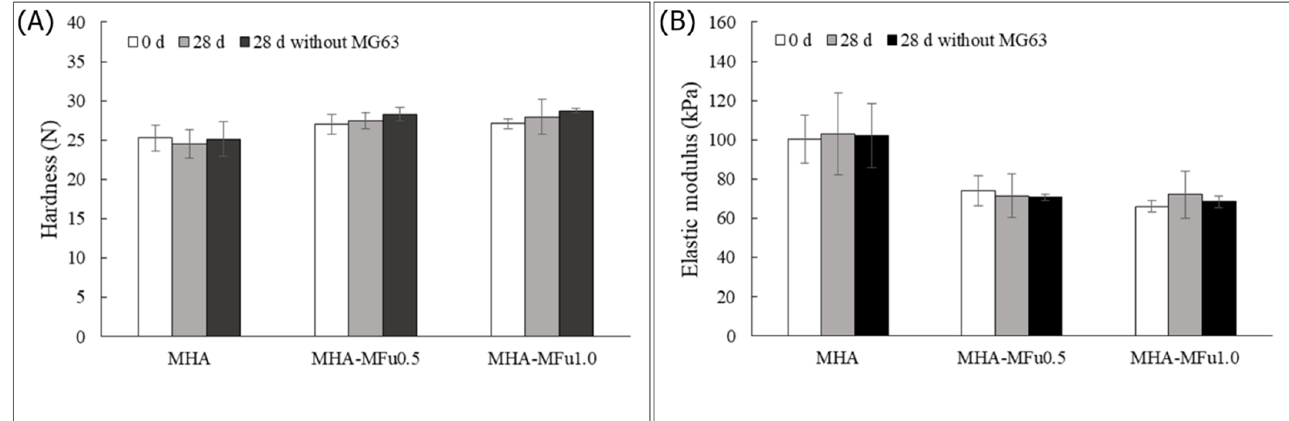
Figure 5. The mechanical properties of the MHA and MHA-MFu hydrogel formulations ( A ) hardness and ( B ) elastic modulus with MG63 cells after 28 days. There was no significant difference between 0 d and 28 d with cells and 28 d without cells.